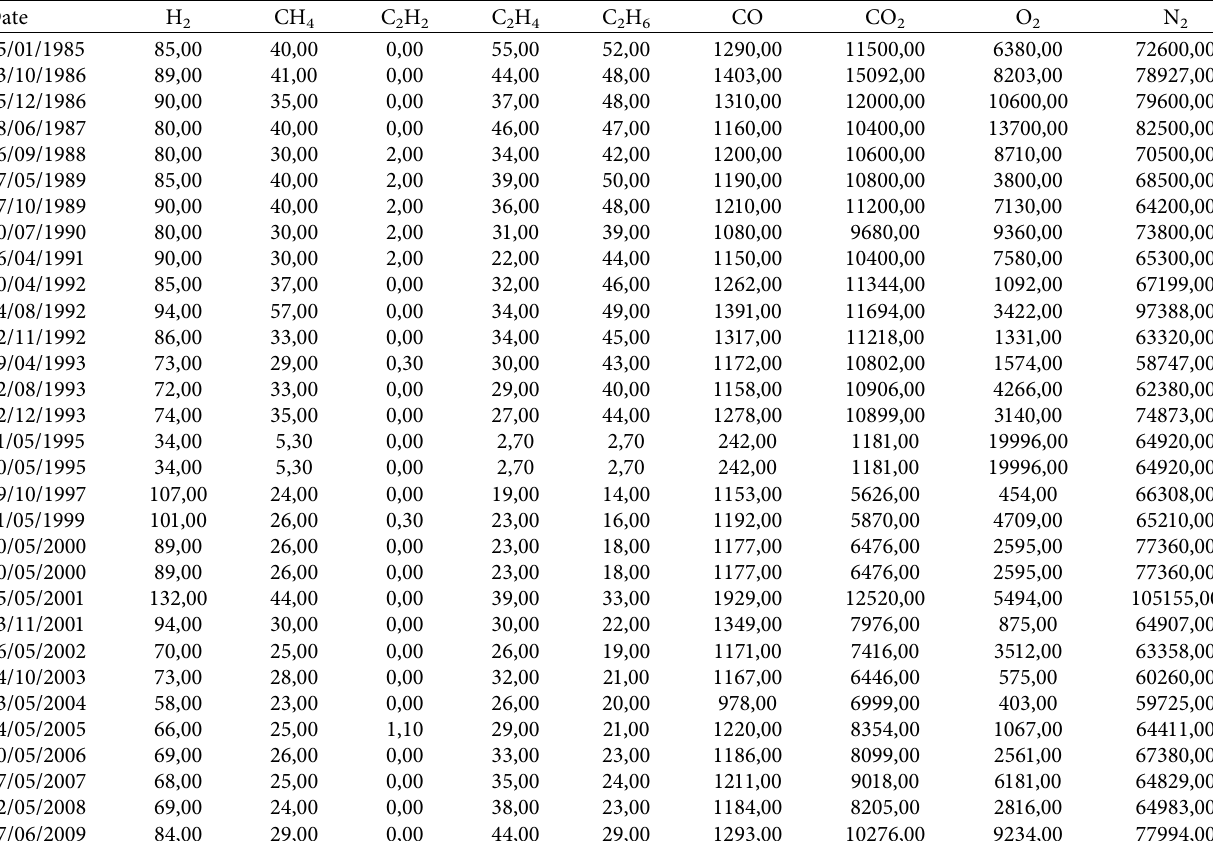
Table 1: RIO Tinto Alcan of Canada database of dissolved gases from transformer T0001.